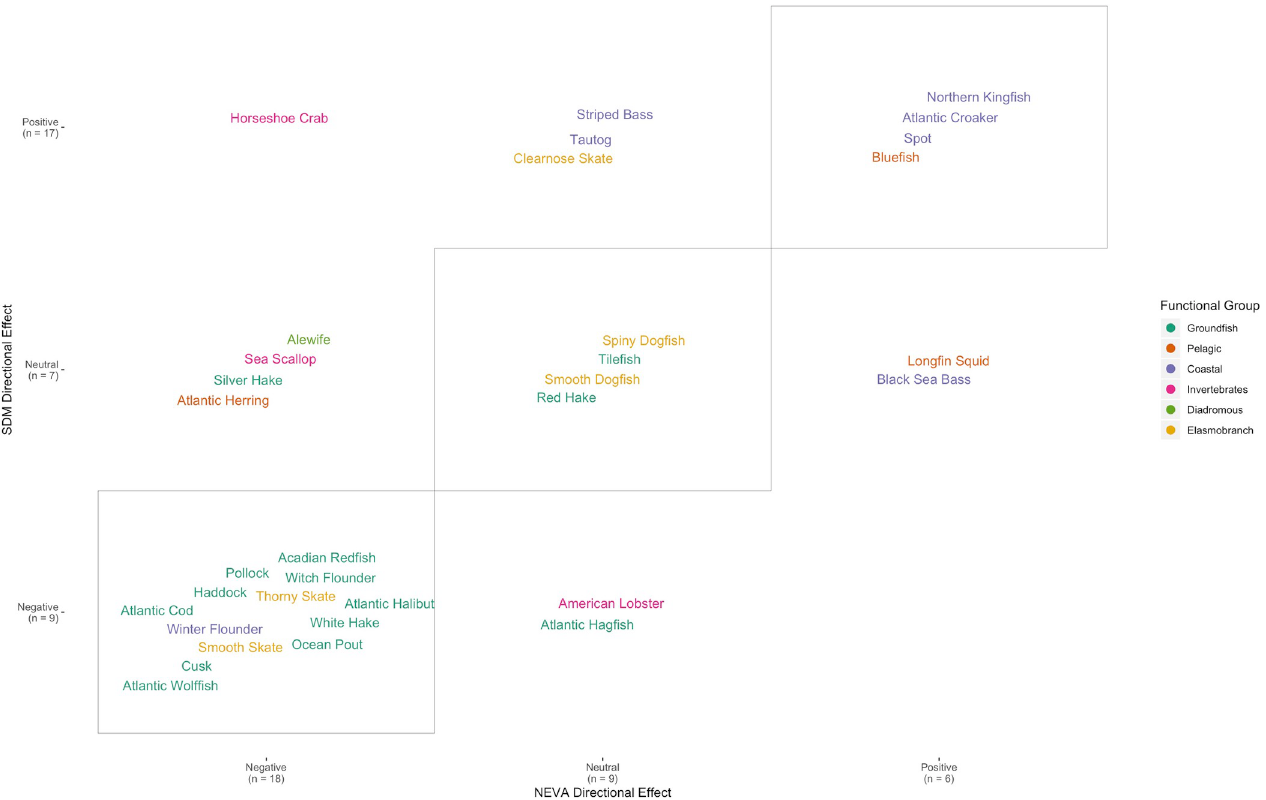
Fig 10. A comparison of directional effect bin assignments as determined from the quantitative species distribution model (SDM directional effect) and from the qualitative expert vulnerability assessments (NEVA directional effect). Bordered diagonal tiles highlight species with matching directional effect classifications between the two approaches. Along with the species names, the number of species in each directional effect bin are shown in parentheses.